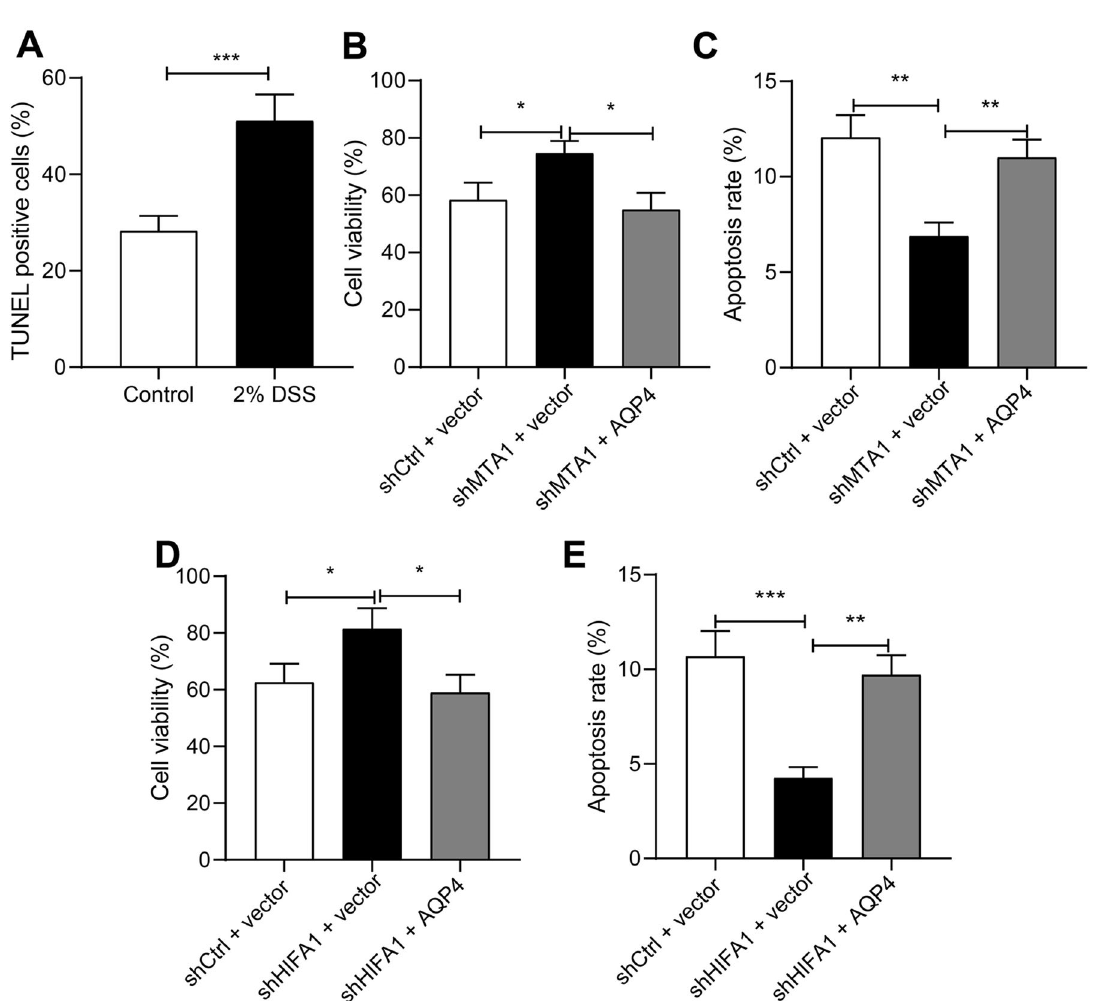
Fig. 5 MTA1/HIF1A/AQP4 promotes the apoptosis of colon epithelial cells. A TUNEL staining of the cell apoptosis of colon tissue in DSS- induced experimental colitis. B The cell viability rate detected by CCK-8 assay in LPS-treated cells with MTA1 silencing. C The apoptotic rate detected by fl ow cytometry in LPS-treated cells with MTA1 silencing. D The cell viability rate detected by CCK-8 assay after AQP4 was overexpressed in LPS-treated cells with MTA1 silencing. E The apoptotic rate detected by fl ow cytometry after AQP4 was overexpressed in LPS-treated cells with MTA1 silencing. * p < 0.05; ** p < 0.01; *** p < 0.001. The measurement data were expressed as mean ± standard deviation. Data between two groups were compared by the unpaired student ’ s t test, and data among multiple groups were compared by one-way ANOVA, followed by Tukey ’ s post hoc tests. The experiment was conducted three times